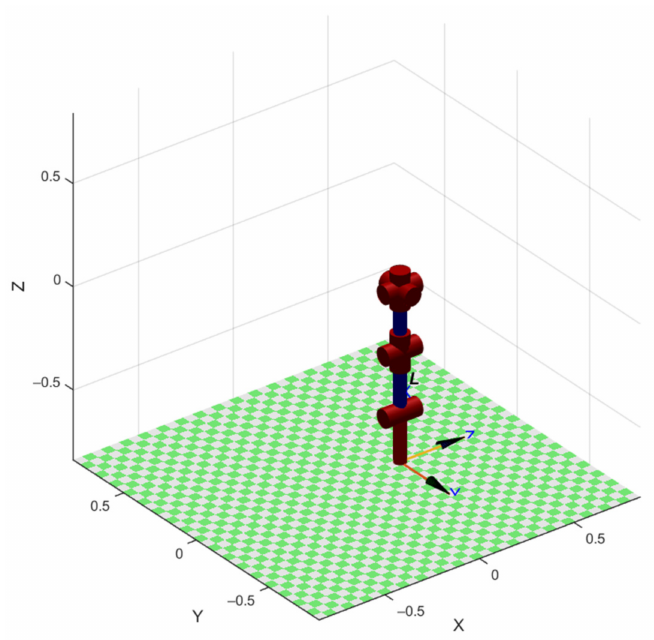
Figure 6. The computer model of the initial position of the robot SAR-401 left